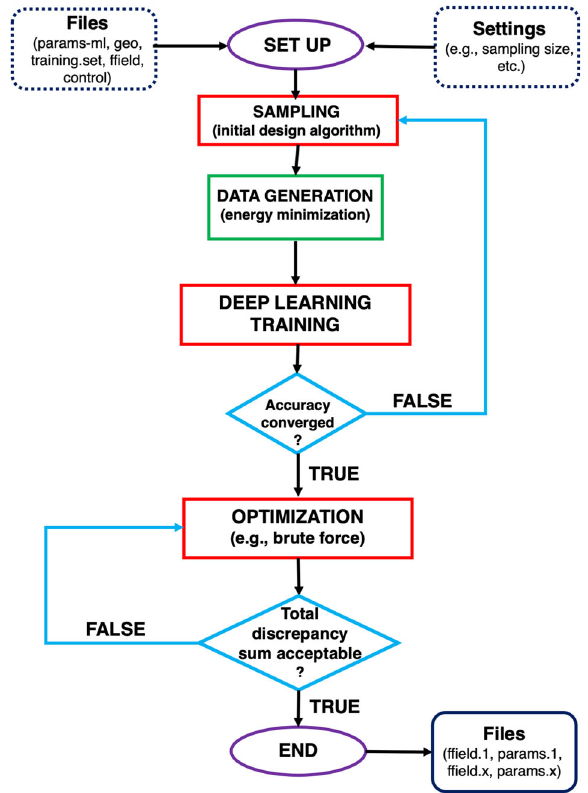
Fig. 3 The fl ow diagram of INDEEDopt framework showing all stages of the algorithm. Flow diagram of INDEEDopt framework. Red boxes represent the three main stages of the framework: sampling with initial design algorithms, deep learning model training, and optimization using brute-force method. Blue diamonds represent the conditional transition points in the algorithm. Dark blue dashed boxes represent input fi les and settings given by the FF developer. The input fi les that are used in INDEEDopt are same as the ones used in conventional method. Dark blue box represents output fi les, which are the optimized force fi eld parameters. The fl ow diagram of INDEEDopt is in alignment with on-the- fl y learning schemes. Still, it is conceptually innovative due to smartly designing the parameter search and use these data to train a DL model, which is further used for optimization purposes.